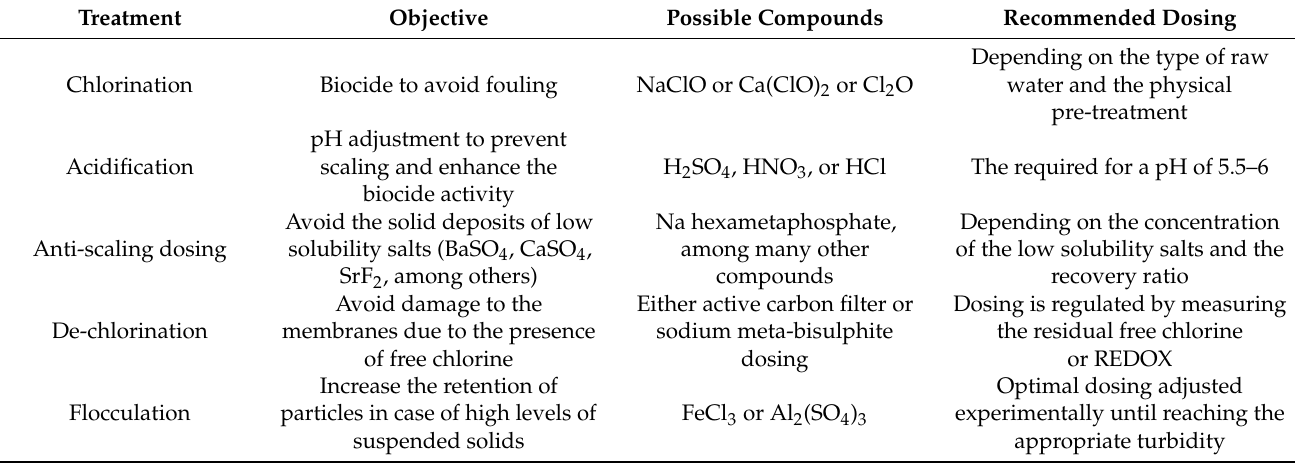
Figure 1. Schematic diagram of physical and chemical pre-treatment in an SWRO desalination plant (source: own elaboration adapted from [39]). Table 4. Summary of the chemical